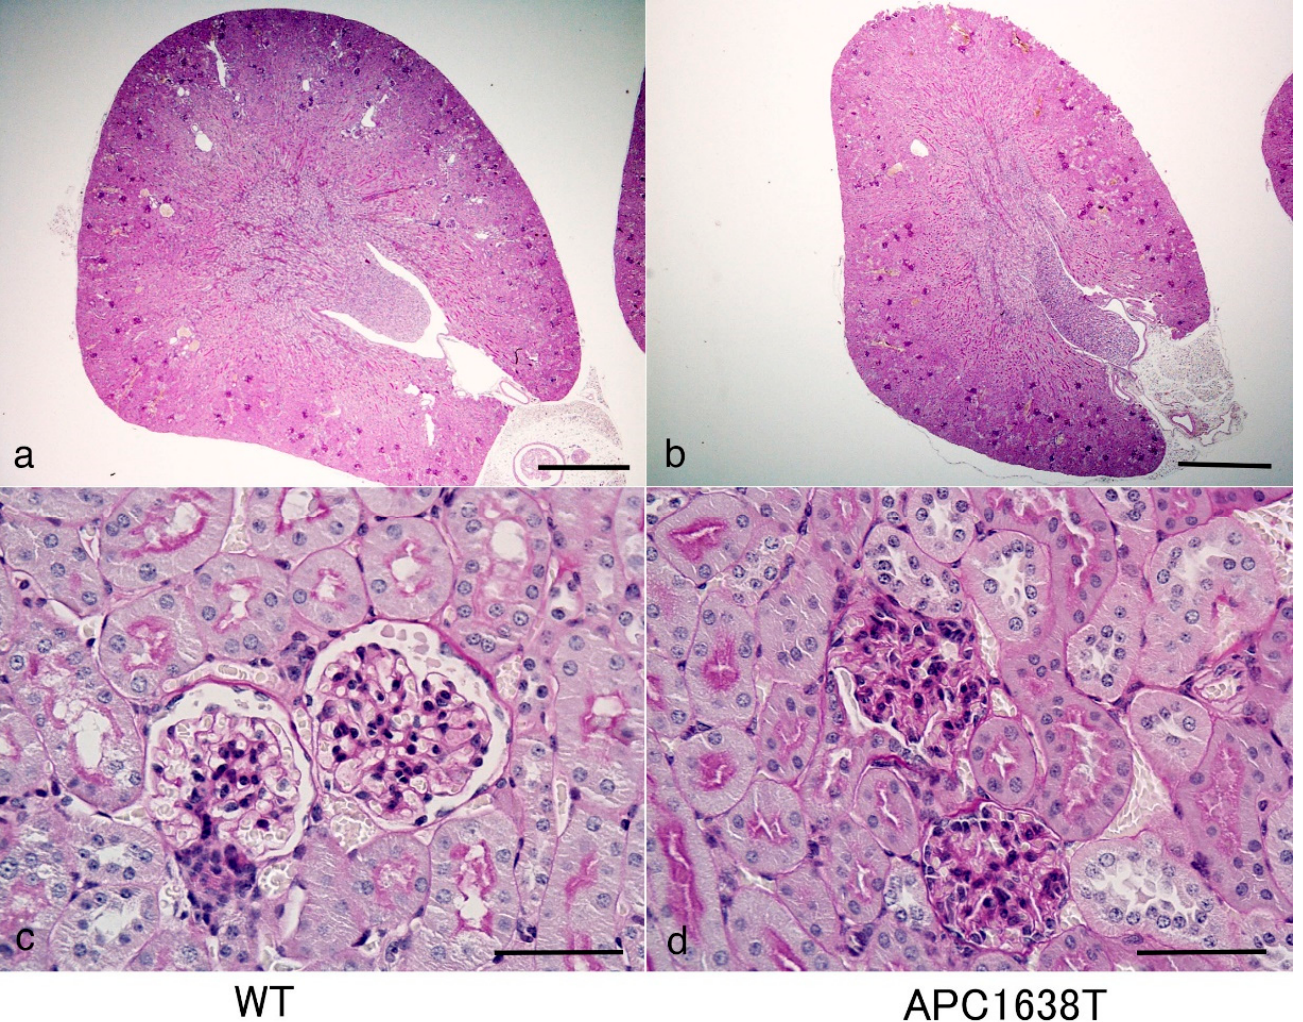
Figure 1. Periodic acid Schiff (PAS) staining of the kidney of wild-type (WT, ( a , c )) and APC1638T mice ( b , d ). The bars indicate 500 μ m ( a , b ) and 50 μ m ( c , d ).